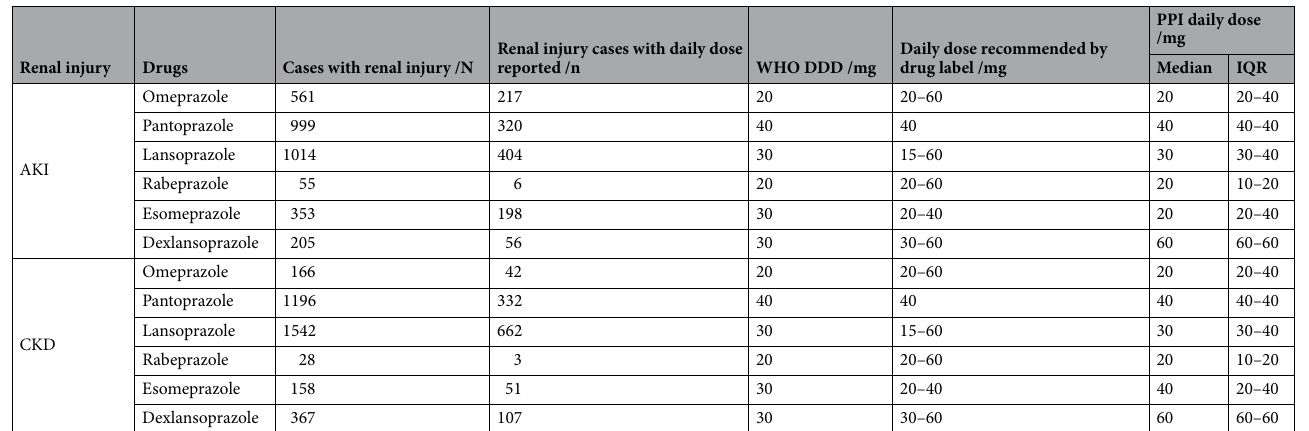
Table 4. Daily dose of PPIs from FAERS database. PPIs proton pump inhibitors, AKI acute kidney injury, CKD chronic kidney disease, DDD defined daily dose IQR: interquartile